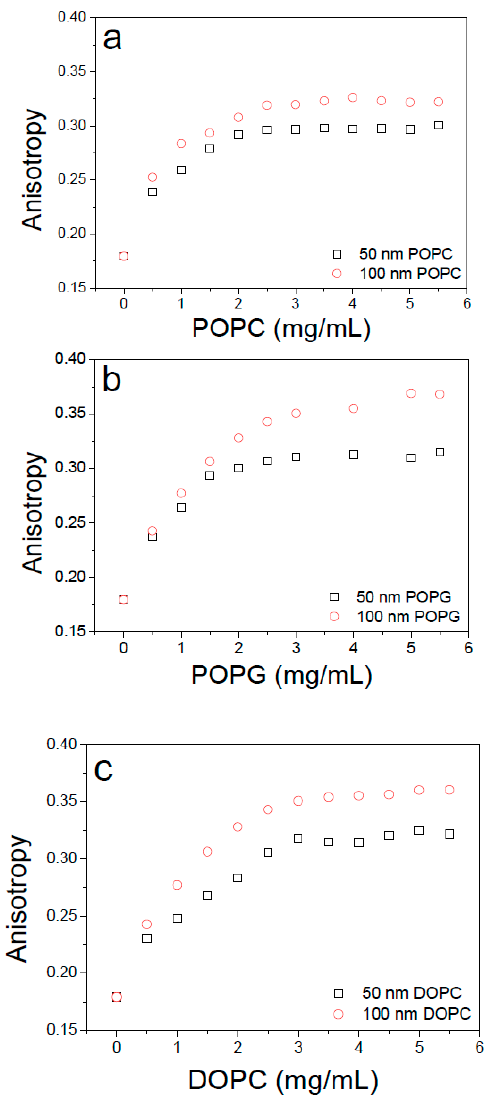
Figure 4. The fluorescence anisotropy of TAMRA-bR incorporated in an increasing concentration